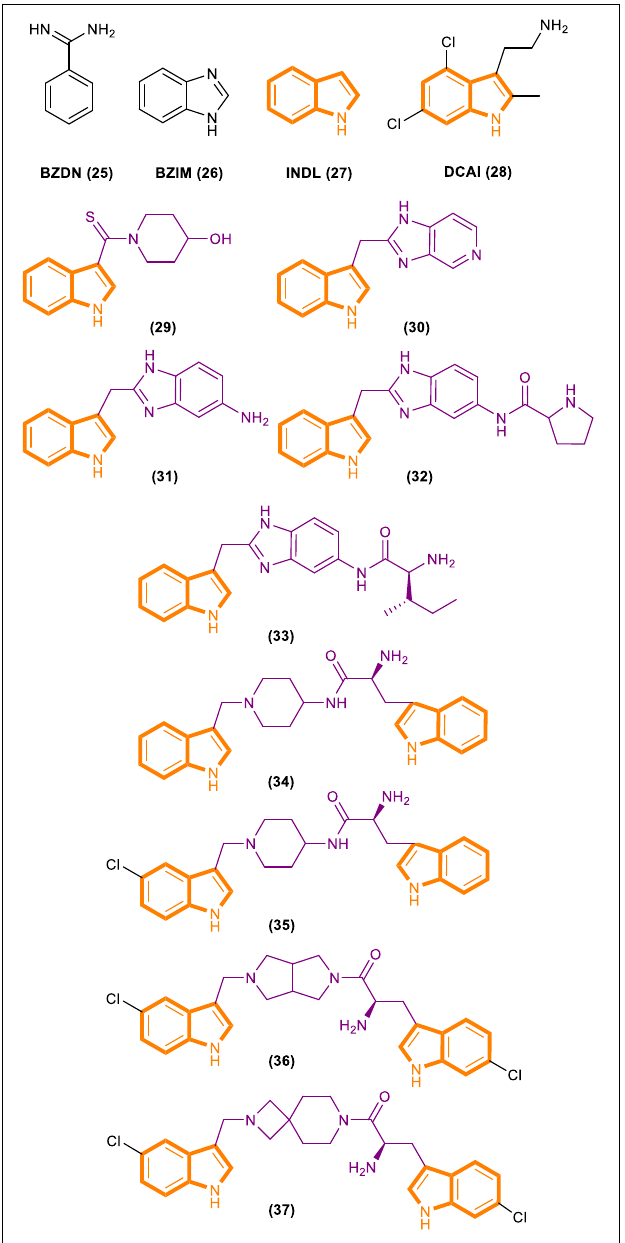
FIGURE 7 | Structures of BZDN, BZIM, INDL, DCAI, Benzimidazole-indole analogs (29–33) and Aminopiperidine–indole analogs (34–37).